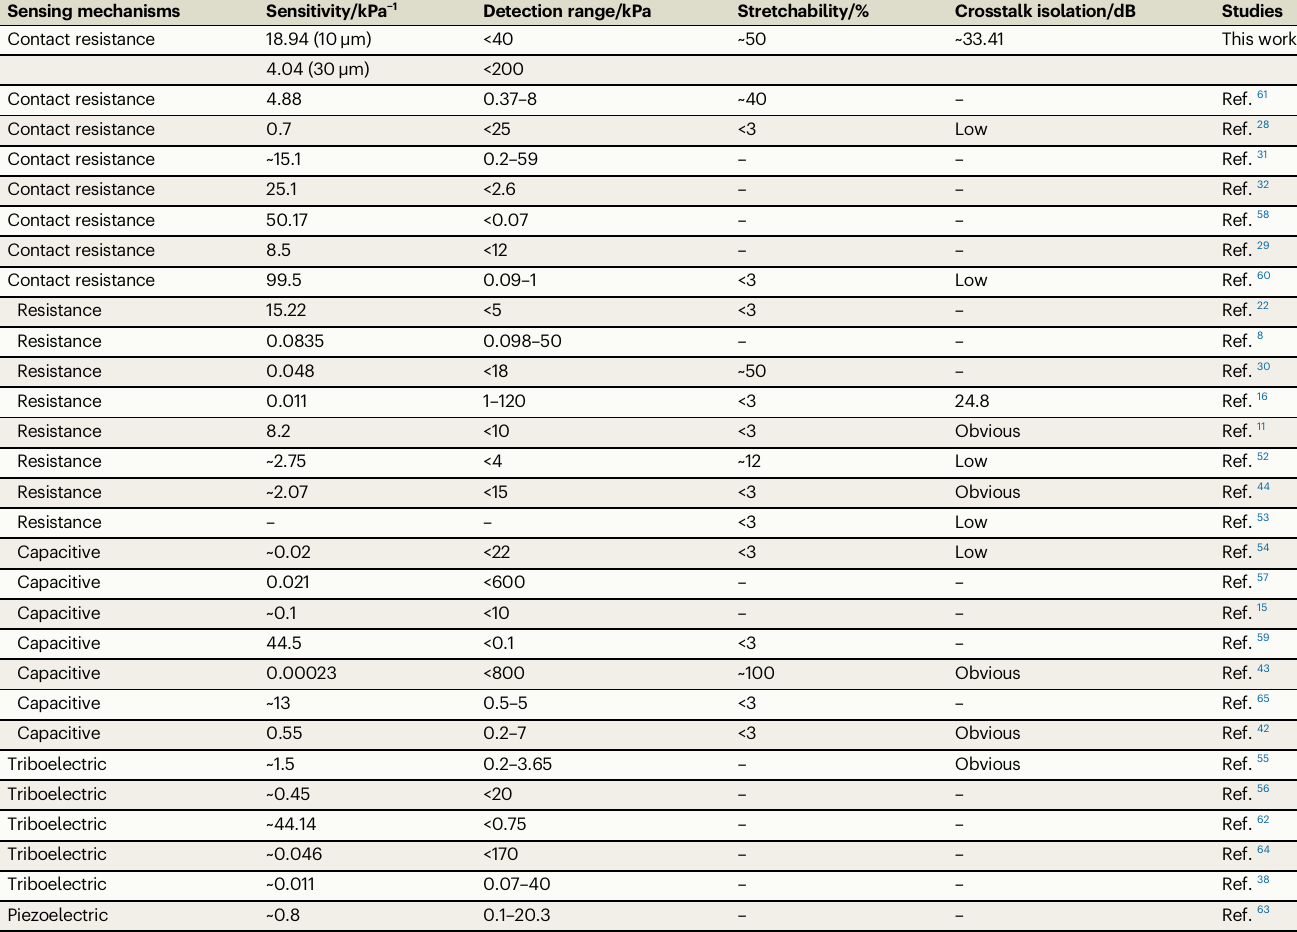
Table 1 | Performance comparison with state-of-the-art pressure sensor Sensing mechanisms